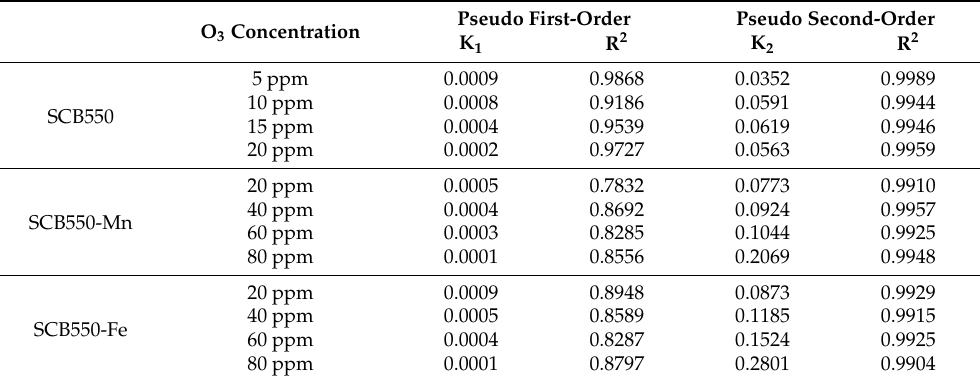
Table 5. Summary of adsorption kinetics modeling parameters.